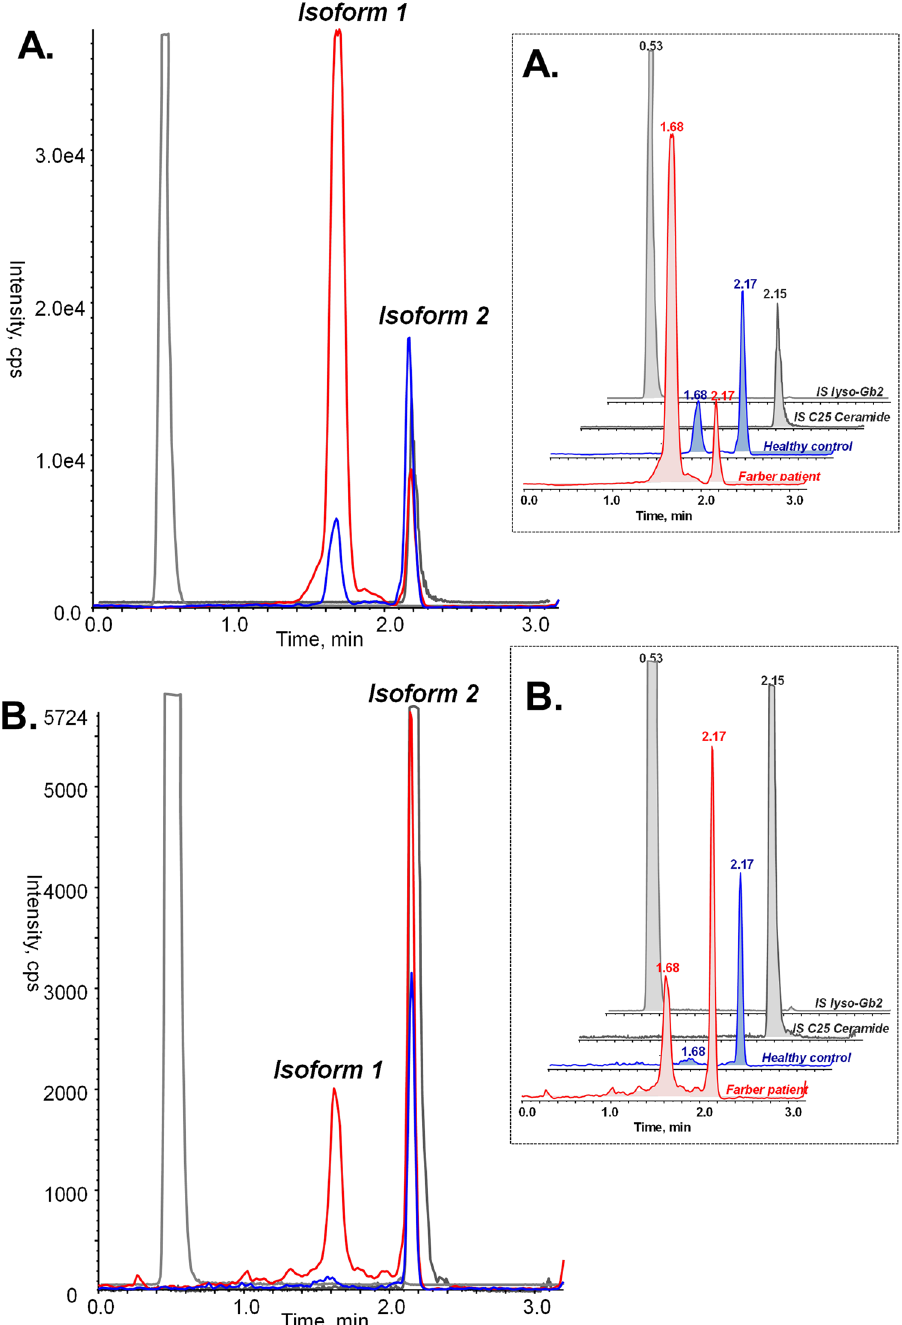
Figure 1. TIC (total ion chromatogram) profile of C26-ceramide isoforms in samples from genetically confirmed Farber patient vs normal control: ( A )-in DBS; ( B )-in clear plasma. In DBS, both isoforms were present in both samples from healthy controls (blue) and Farber patients (red), the two internal standards are represented in grey. Isoform 1 was dominant in the Farber samples, while isoform 2 was dominant in healthy